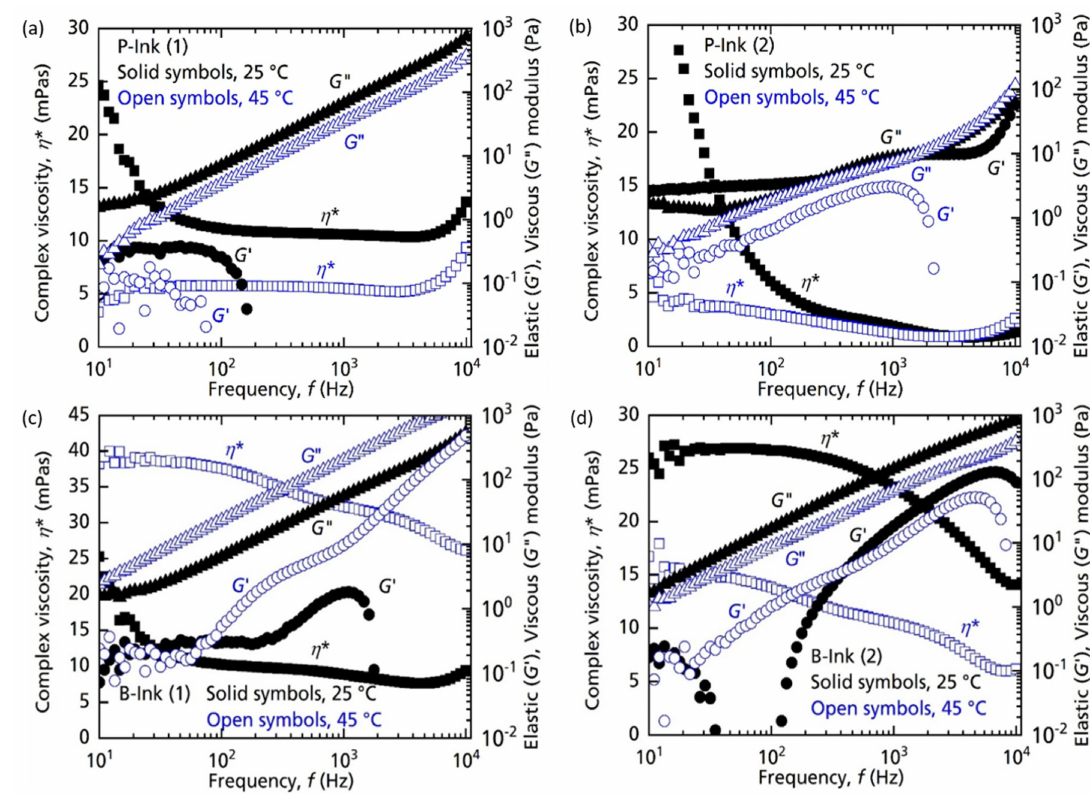
Figure 11. Evolution of the rheological flow curves with a rise in temperature. Complex viscosity ( η * ), elastic ( G (cid:48) ) and viscous ( G ”) modulus measurements of ( a ) P-ink (1), ( b ) P-ink (2), ( c ) B-ink (1) and ( d ) B-ink (2), with respect to frequency ( f ) at 25 ◦ C and 45 ◦ C as measured by the PAV